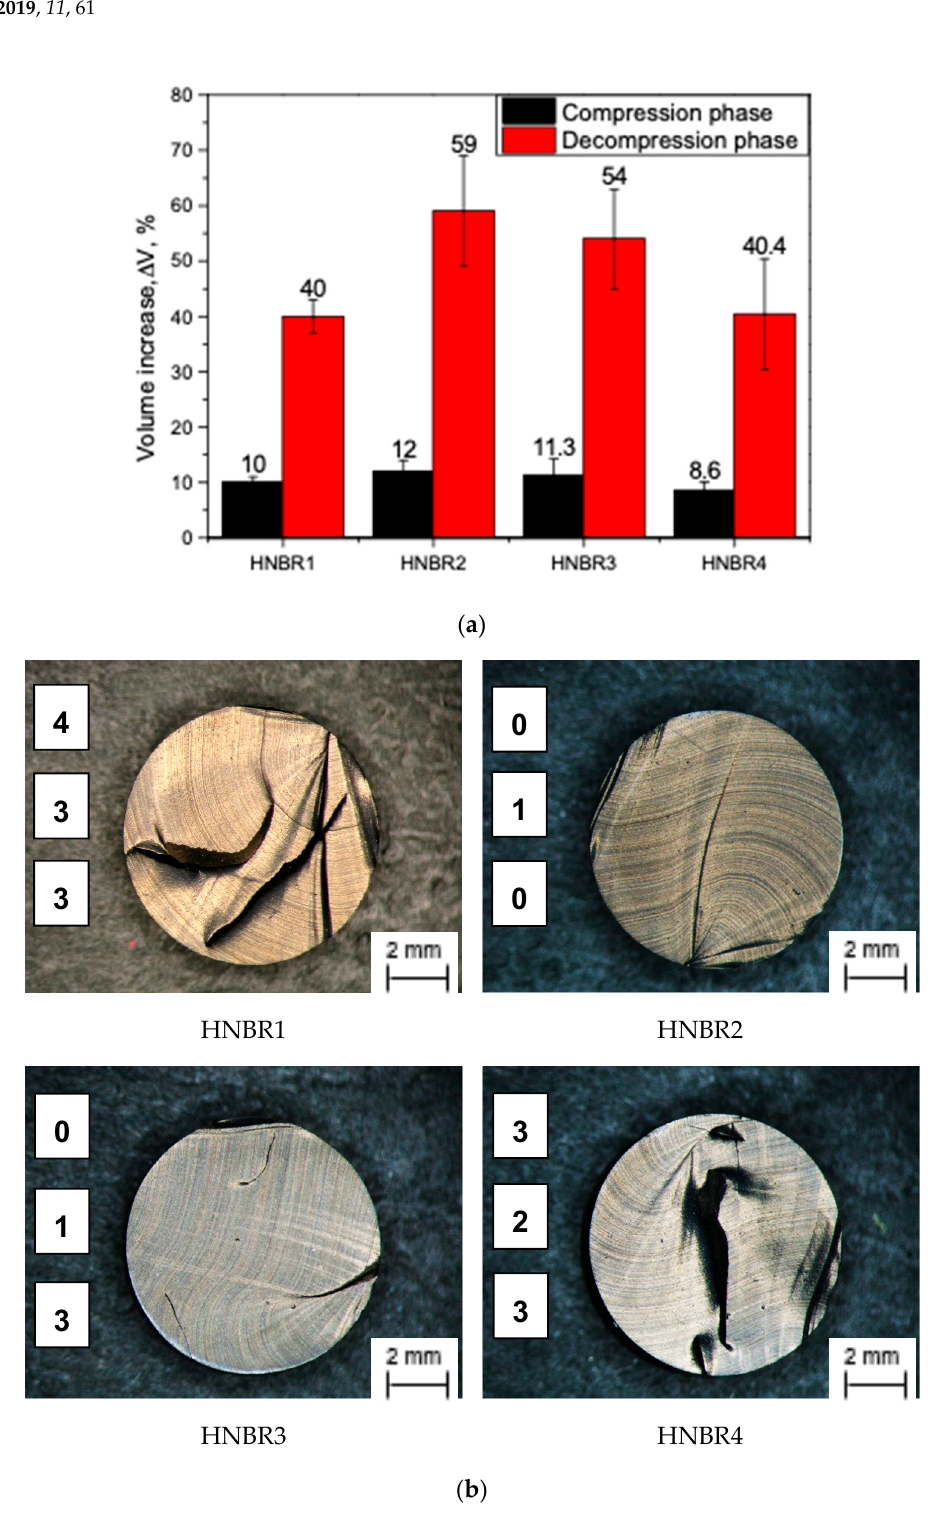
Figure 5. Influence of CB grades composition on rapid gas decompression (RGD) performance of HNBR: ( a ) volume increase during compression ( ∆ VC) and decompression ( ∆ VD); ( b ) visual observation of cylindrical specimens and the NORSOK material ranking (every number on the right represents a different measurement).